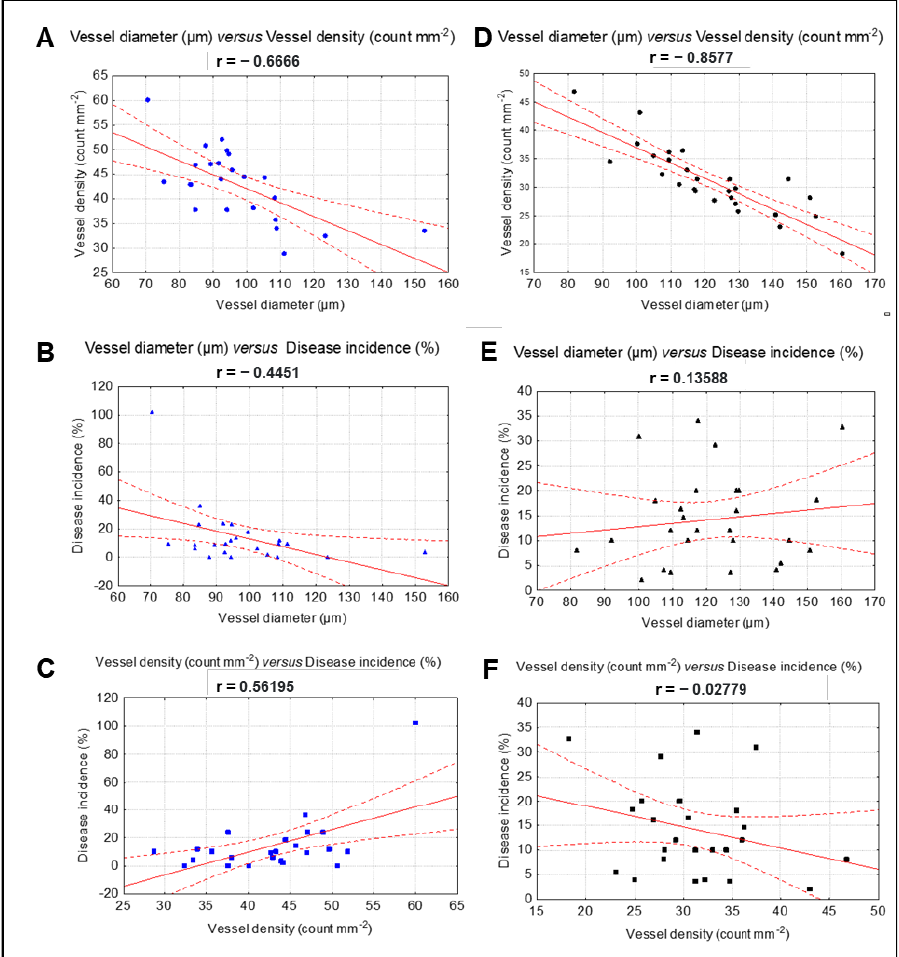
Figure 8. Pearson’s correlations between vessel diameters and vessel densities ( A , D ), vessel diameters and disease incidence ( B , E ), and disease incidence and vessel densities ( C , F ) in the red-berried cultivars ( A , B , C ) and white-berried cultivars ( D , E , F ). 254 3.4. Comparisons Among Red-Berried and White-Berried Cultivars 255 Vessel diameter and vessel density — The comparison between red-berried and 256 white-berried cultivars highlighted significant differences between the two groups. The 257 vessel diameter average values were 121.9 µm for white-berried and 97.0 µm for red-ber- 258 ried cultivars (Figure 9A). Regarding the vessel density, red-berried cultivars showed a